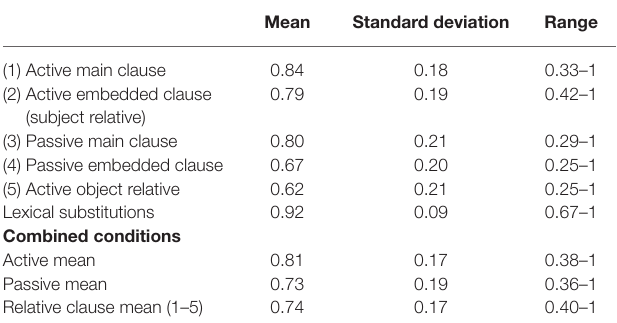
TABLE 7 | Descriptive statistics for performance on each trial type in the relative clause sentence comprehension task ( N = 67, except lexical substitutions N = 47).